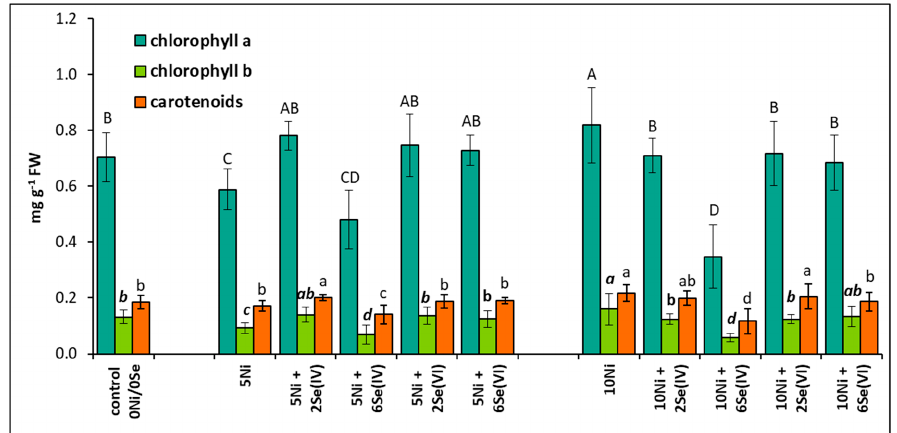
Figure 2. Effect of Se supplementation on the concentration of photosynthetic pigments in Ni-exposed lettuce after 14 days of exposure. Data are means ± SD ( n = 6). Means for individual pigment classes followed by the same letter are not significantly di ff erent ( p < 0.05, Tukey’s test).